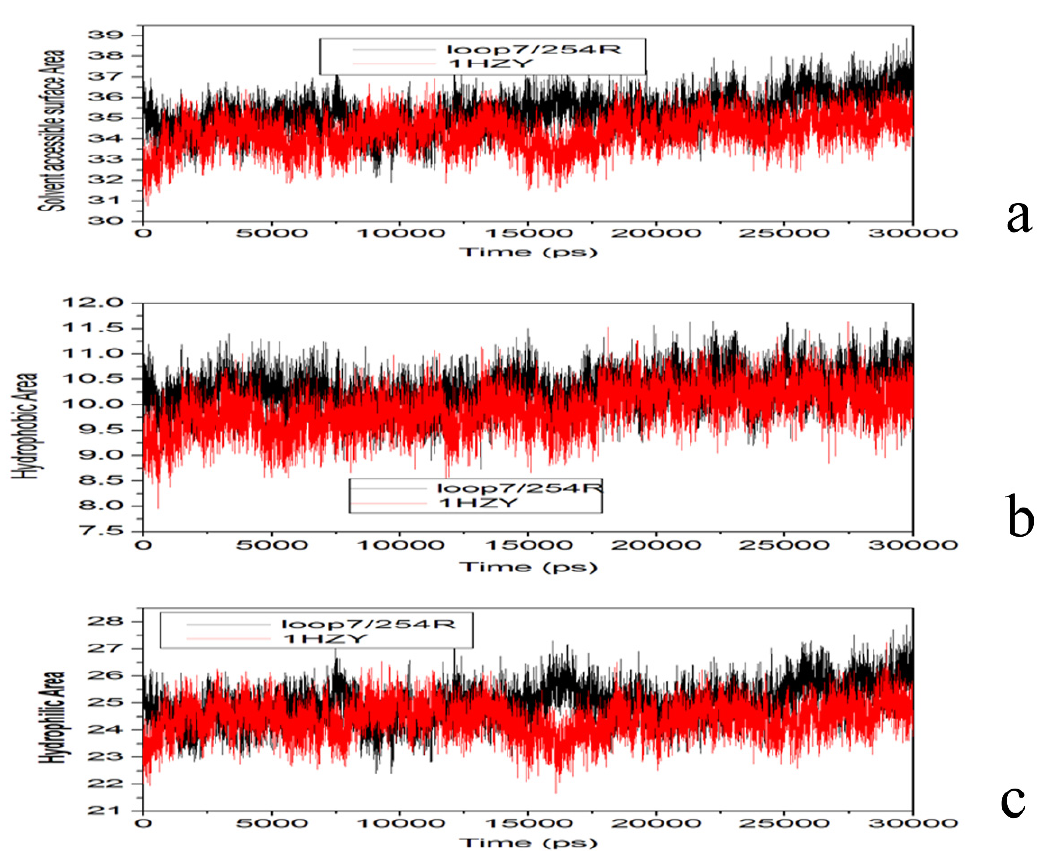
Figure 10. ( a ) Solvent accessible surface area. PTE (red), loop 7-2/H254R (black); ( b ) hydrophobic area. PTE (red), loop 7-2/H254R (black); ( c ) hydrophobic area. PTE (red), loop 7-2/H254R